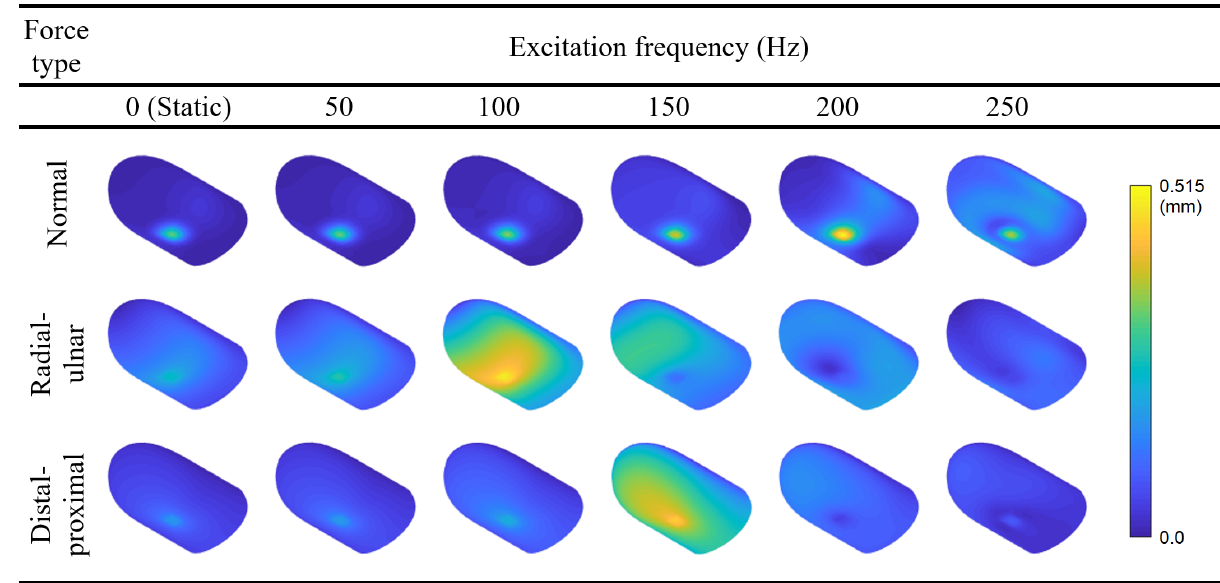
Figure A2. The recolored contours of the forced vibration mode shapes shown in Figure 7. Here, the coloring shows the absolute displacement magnitudes so that the plots can be compared to one